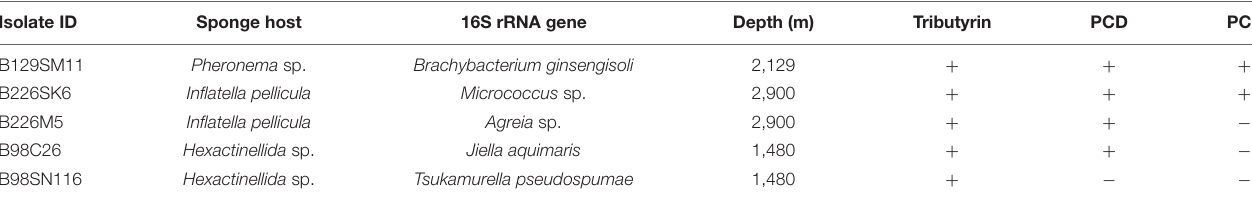
TABLE 1 | Confirmed hydrolytic activities for five isolates derived from deep-sea sponges, which were screened on ester (tributyrin) and polyester (PCD and PCL) substrates to identify potential polyesterase producers. Isolate ID